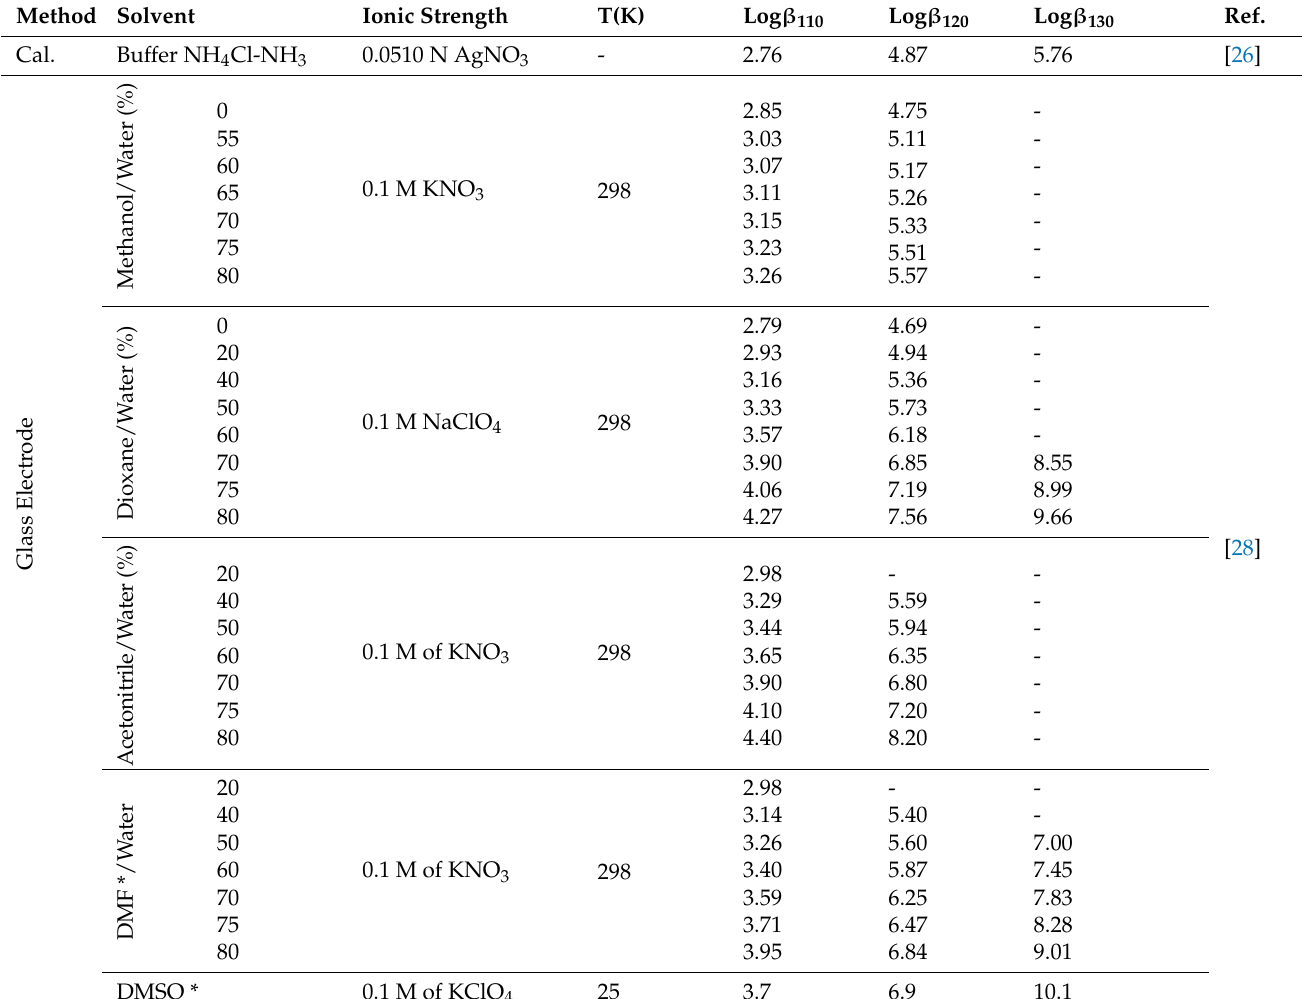
Table 2. Stability constants of the complexes of manganese(II) with ethylenediamine under sev- eral